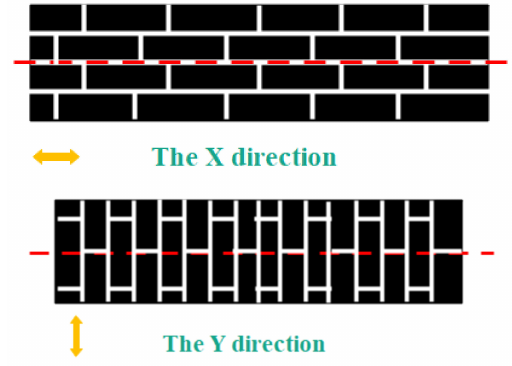
Figure 2. Schematic diagram of fiber orientation.